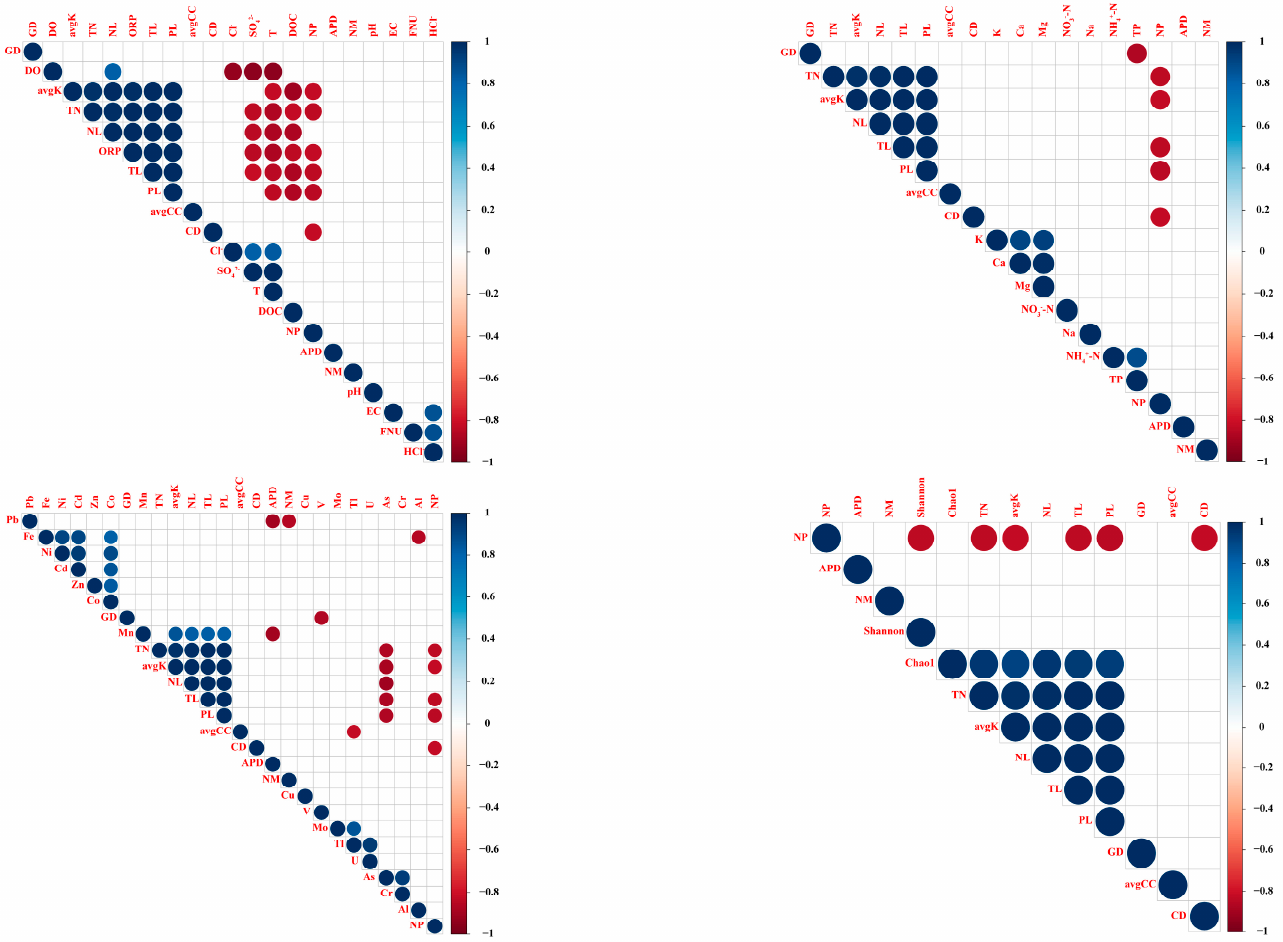
Figure 5. Pearson’s correlation values between network indexes (including GD, avgK, TNs, NLs, TLs, PLs, avgCC, CD, NP, APD and NMs) and the water chemistry parameters (including DO, ORP, Cl − , SO 4 2 − , T, DOC, pH, EC, FUN and HCl − ), nutrient variables (including K, Ca, Mg, NO 3 − -N, Na, NH 4+ -N and TP), heavy metals (including Pb, Fe, Ni, Cd, Zn, Co, Mn, Cu, V, Mo, Ti, U, As, Cr and Al) and diversity index (including Shannon index and Chao1 index), respectively.